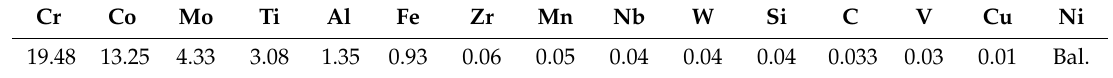
Table 1. Chemical composition of Waspaloy alloy used in this study (wt.%).